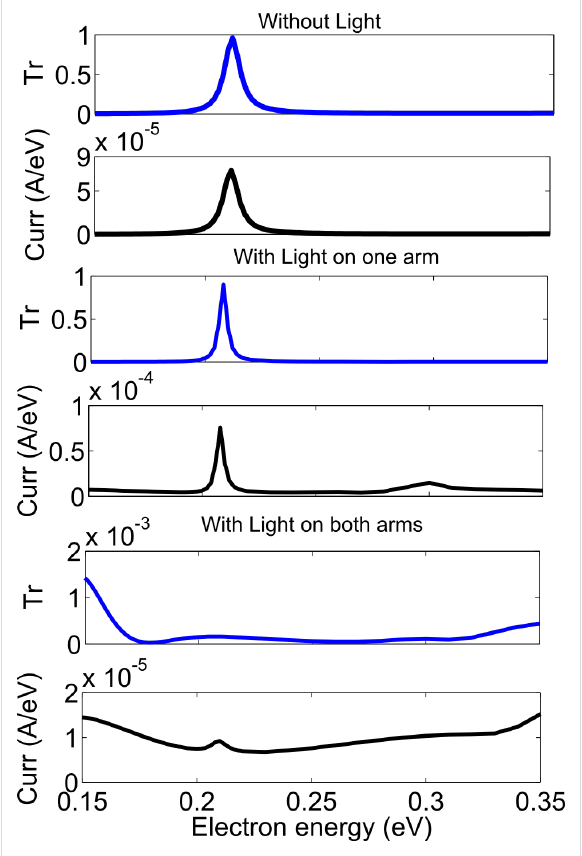
Figure 11: Transmittance and current density vs electron energy for strong photon flux (zigzag